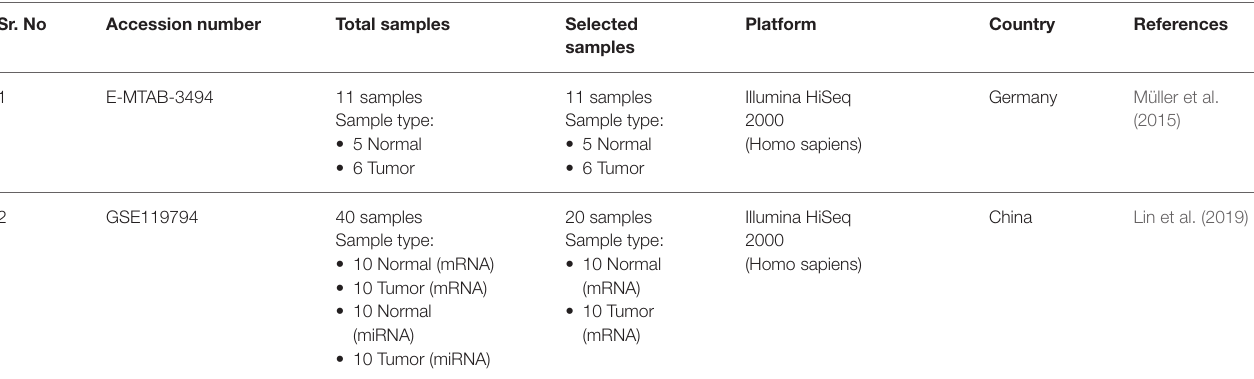
TABLE 2 | RNA-seq